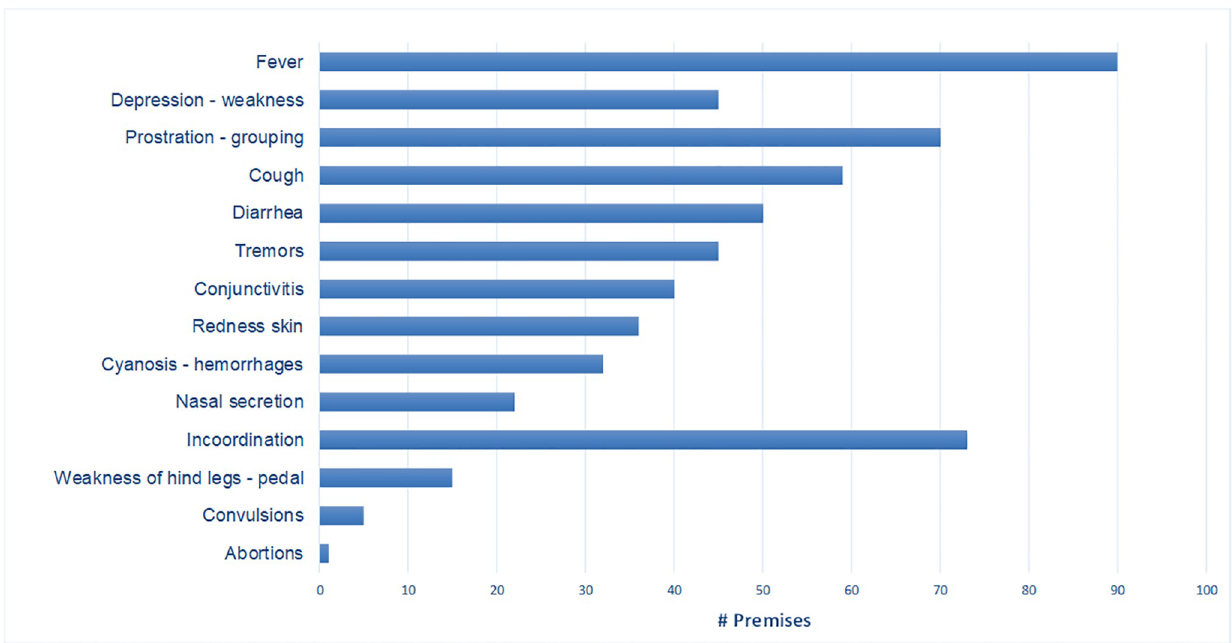
Fig 1. Frequency of clinical signs in the 134 outbreaks of